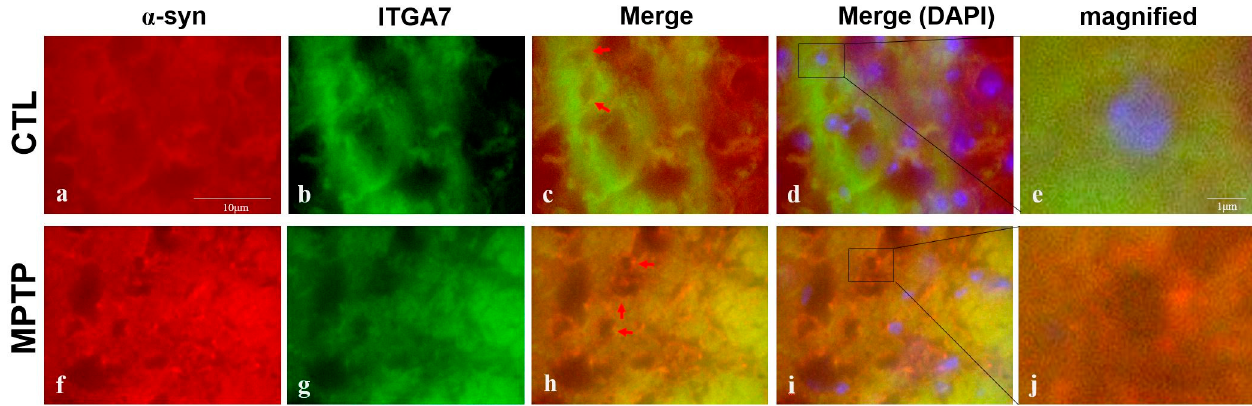
Figure 4. Immunofluorescence images of ITGA7 co-localized with α -syn in the SN in an MPTP-induced Parkinson’s disease mouse model. SN regions were immunofluorescently labeled with anti-ITGA7 ( b , g ) and anti- α -syn ( a , f ) antibodies by using Rhodamine Avidin ( a , f , red) and were then double immunolabeled with ITGA7 antibodies by using Fluorescein Avidin ( b , g , green). The middle panels ( c , h ) show merged images of the individual α -syn ( a , f ) and ITGA7 ( b , g ) panels. In the control group ( c ), ITGA7 was more strongly expressed (green) and in the MPTP group ( h ), intense red fluorescence was observed. ( d , i ) show merged images with DAPI. Images of ( e ) and ( j ) show enlarged images of the square in ( d ) and ( i ). (scale bar, 10 µm).